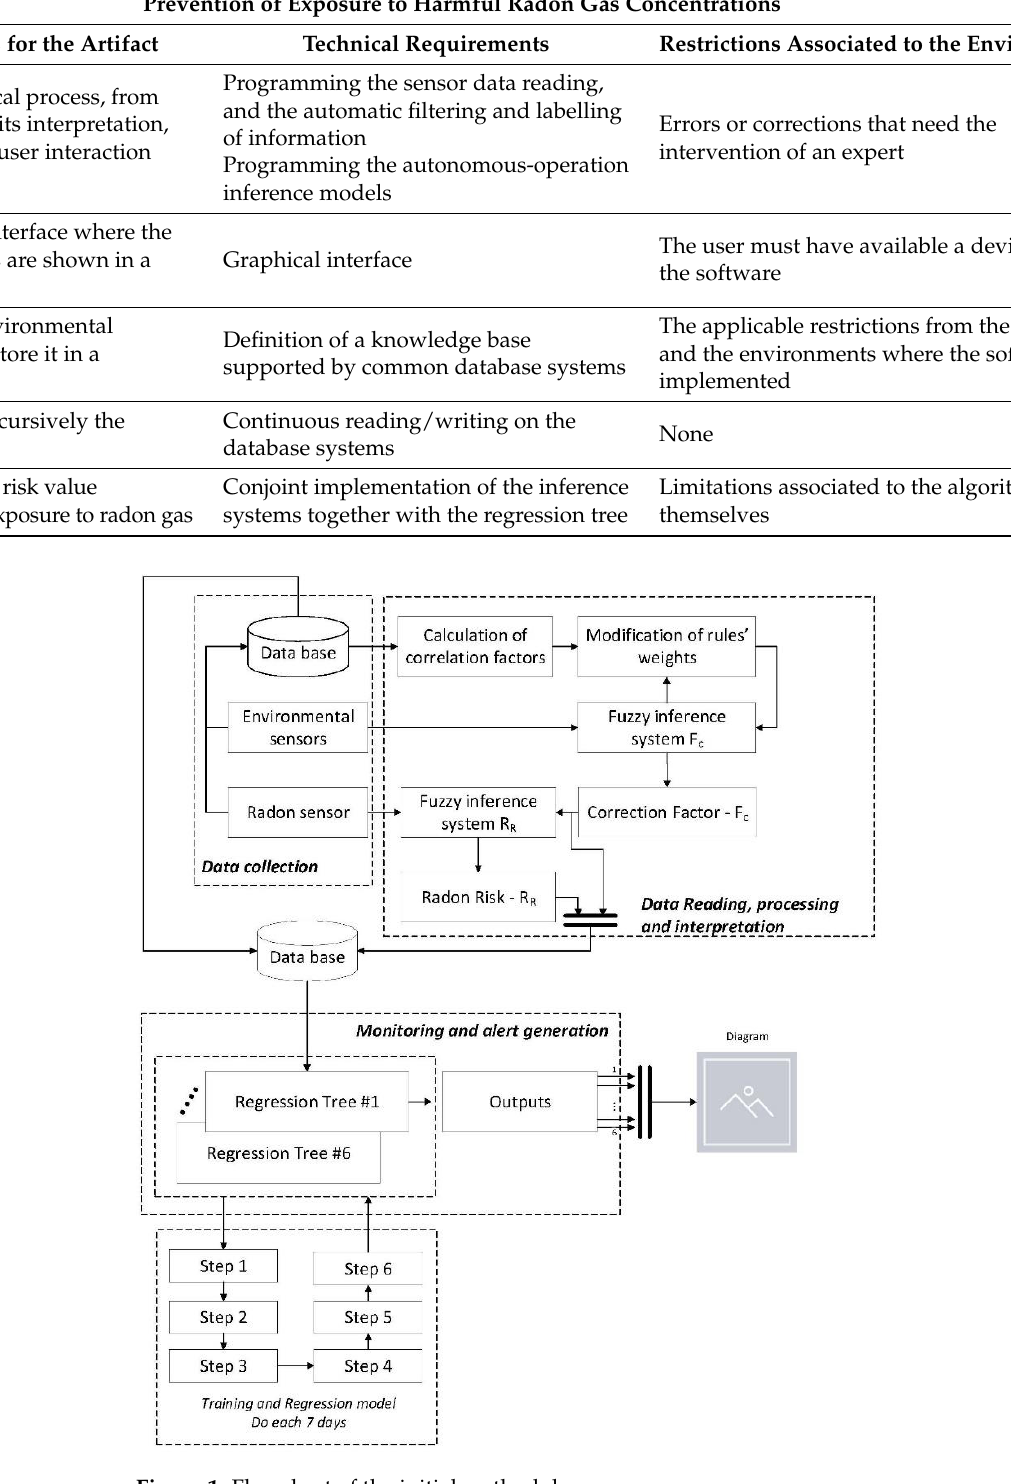
Figure 1. Flowchart of the initial methodology.